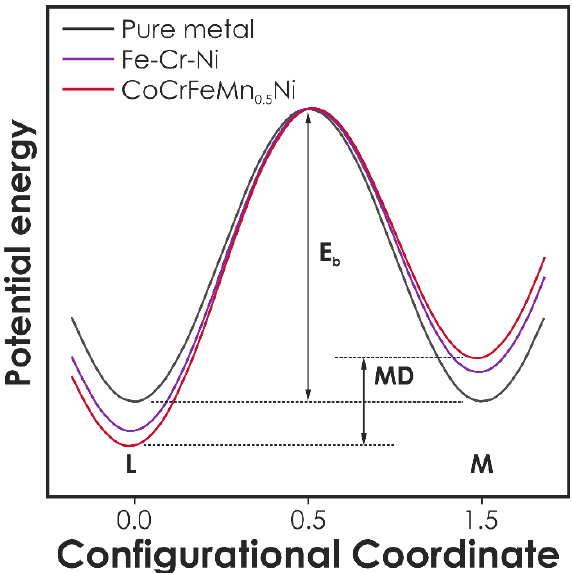
Figure 3. Schematic diagram of the variation of lattice potential energy and mean difference (MD) during the migration of a Ni atom in different matrices (after [28]). Reprinted from Acta Materialia 61 (2013), Sluggish diffusion in Co–Cr–Fe–Mn–Ni high-entropy alloys, 4887–4897 Copyright 2013, with permission from Elsevier.